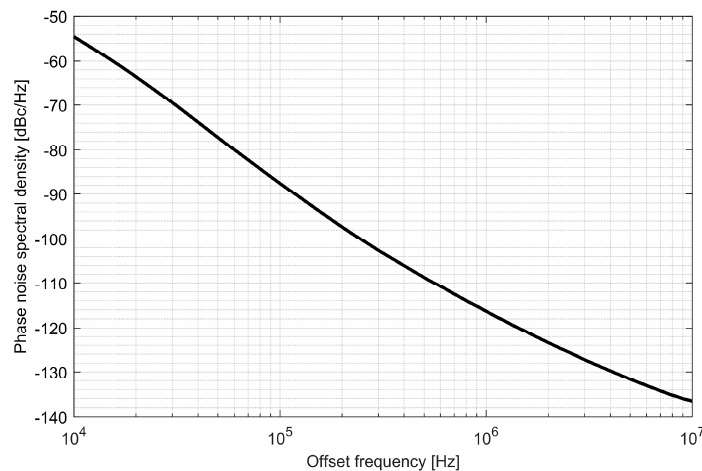
Figure 22. Tuning characteristics of the L5/E5 digitally controlled oscillator.